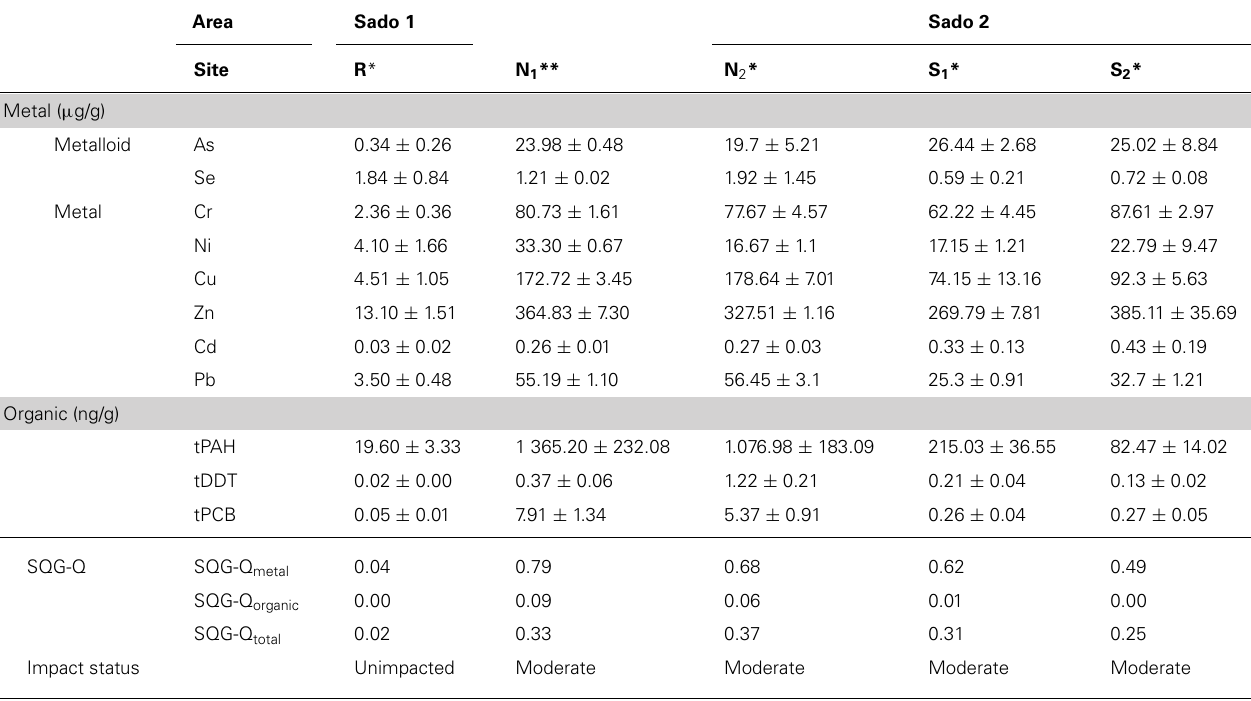
Table 1 | Sediment contamination data and respective sediment quality guideline quotients (SQG-Qs) per sediment